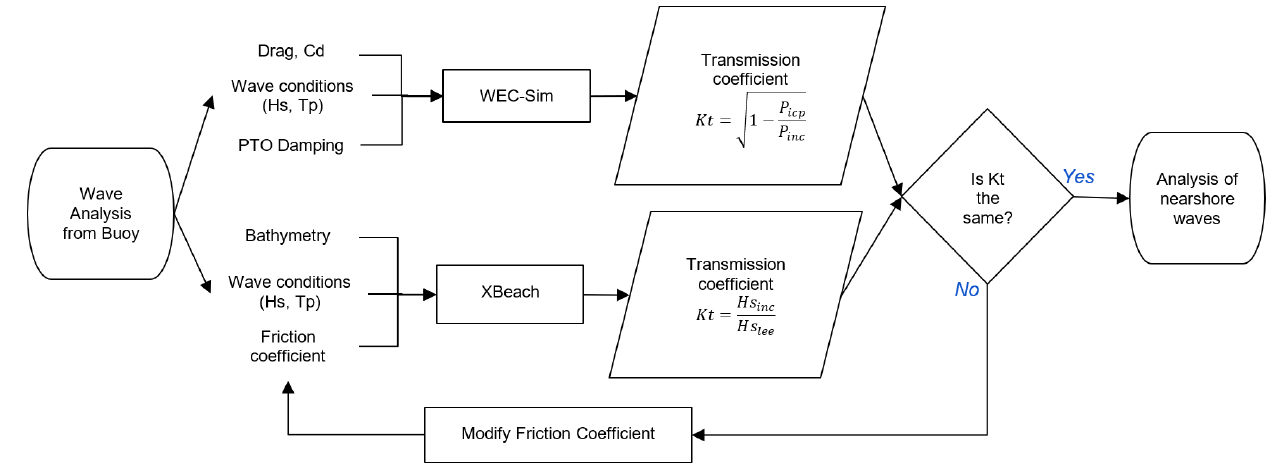
Figure 4. Flow chart depicting the method for soft-coupling WEC–Sim and XBeach. The WEC–Sim trial is run first, and the WEC’s transmission coefficient (Equation (6)) is calculated. Then, the XBeach simulation is run using a randomly chosen friction coefficient. Once the simulation is completed, the average transmission coefficient is calculated (Equation (7)) in XBeach and compared with the K t from WEC–Sim. If the K t is the same, the friction coefficient is maintained. If it is not, the XBeach simulation is run again with a new f w until it matches the WEC–Sim K t